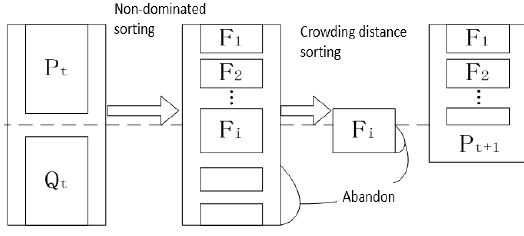
Figure 4. The main process of NSGA-II.